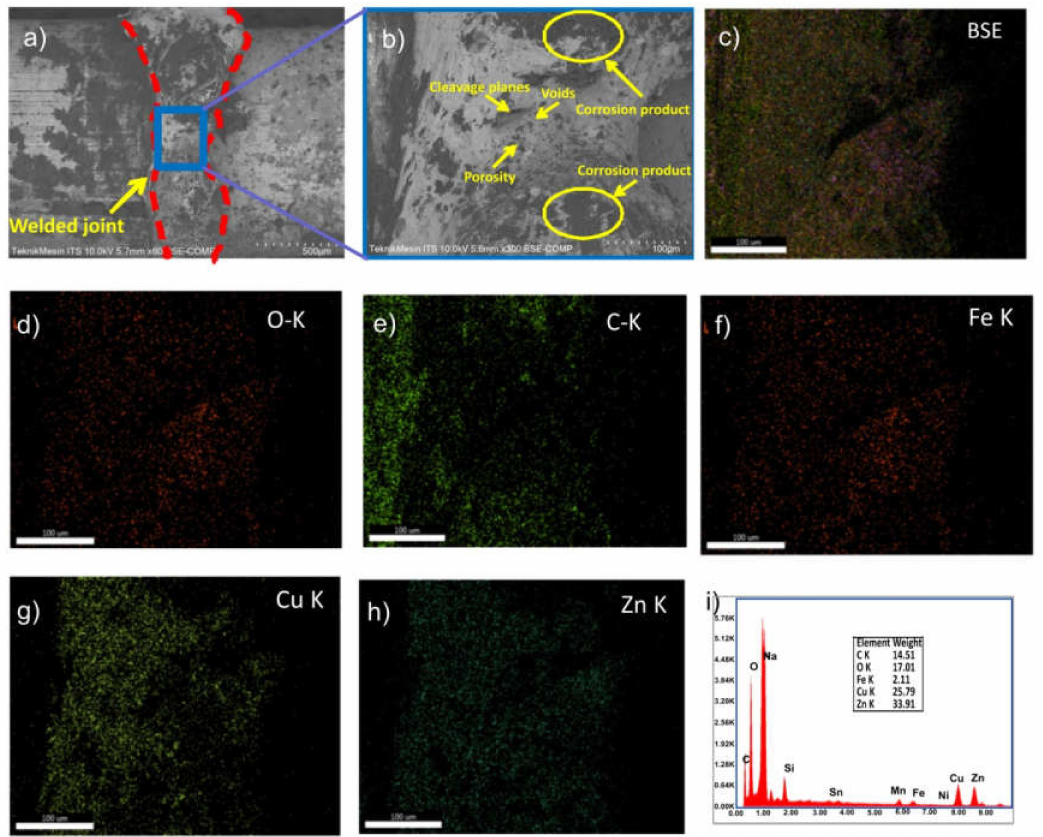
Figure 5. ( a )The micrograph of α 0 using SEM with a 50x magnification, ( b ) 300x magnification, ( c ) color composite of SEM / EDS maps (backscattered electron), ( d ) map of O, ( e ) map of C, ( f ) map of F, ( g ) map of Cu, ( h ) map of Zn using EDS., ( i ) Elements composition of welded